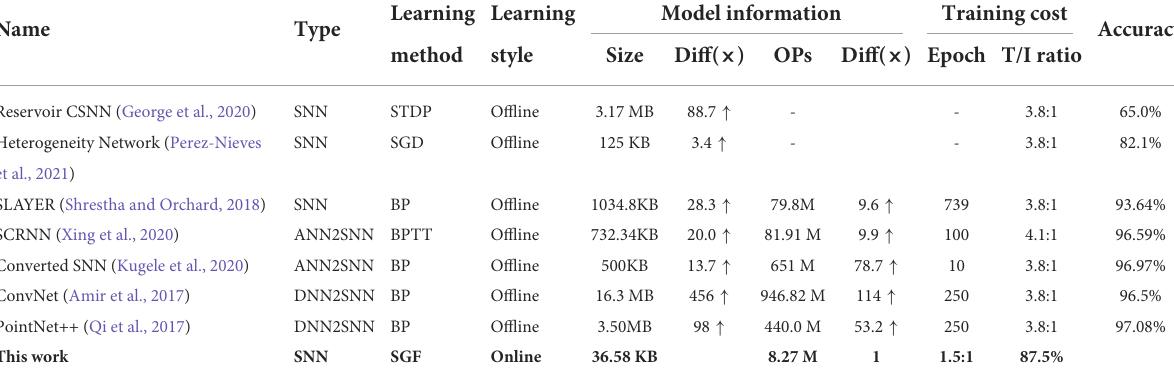
TABLE 2 The comparison between state-of-the-art methods and the proposed spiking gating flow (SGF) network.